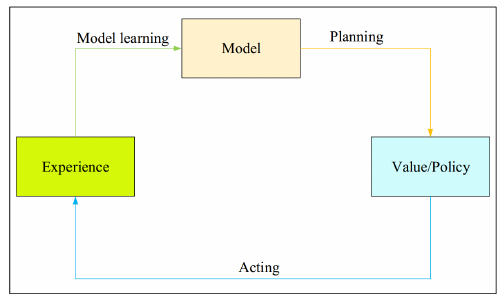
Figure 10. Model-based learning system.